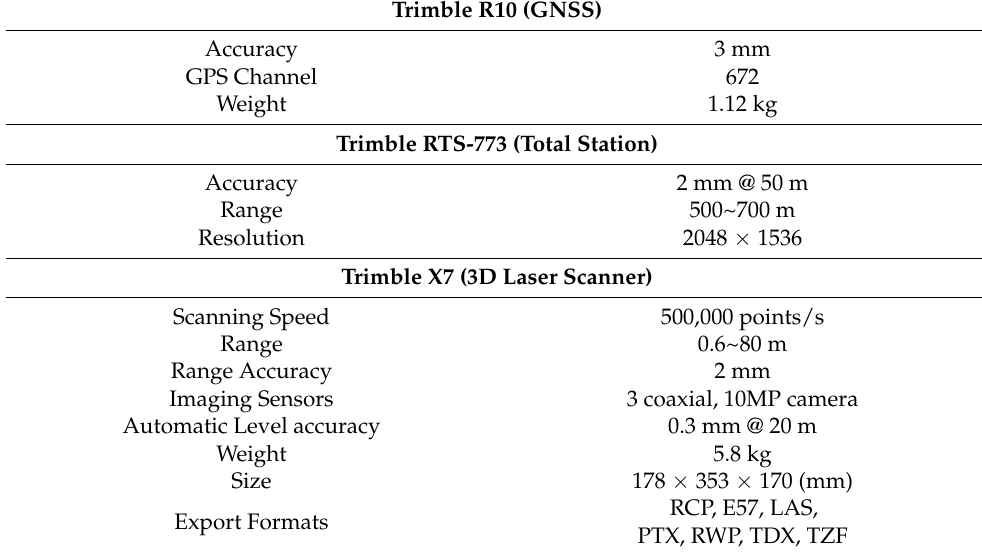
Table 1. Specifications of the